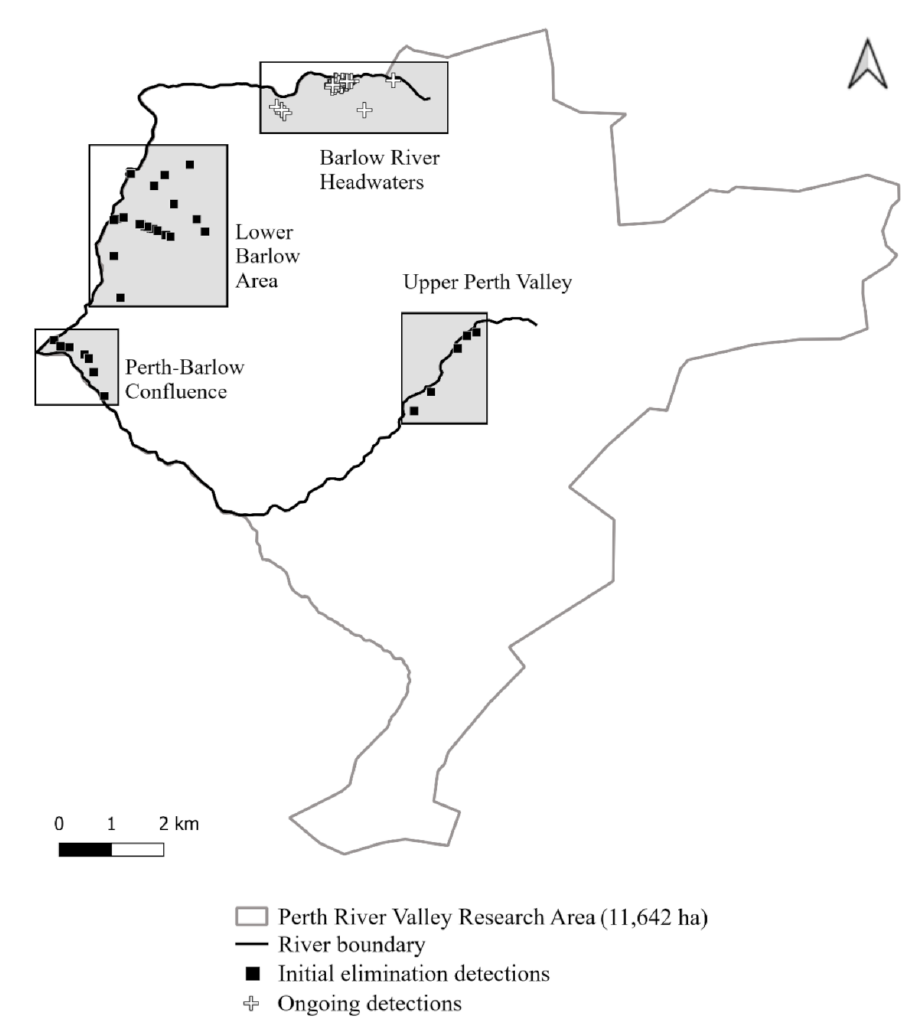
Figure 2. Possum detections in the Perth Valley from 25 August 2019 (first detection following site wide aerial 1080) to 31 August 2020. Shaded squares indicate the discrete areas of the site discussed in the